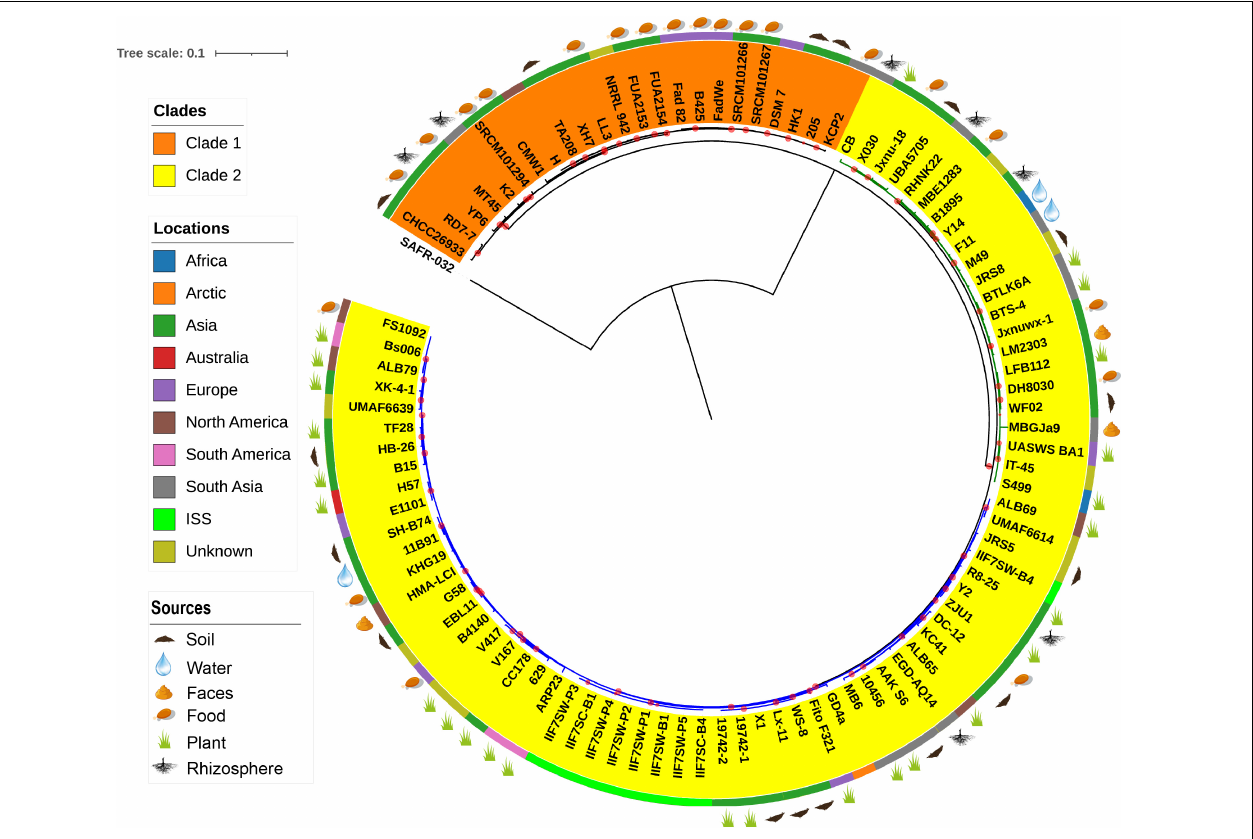
FIGURE 2 | The phylogenetic tree of single-copy core proteins. The maximum-likelihood tree was constructed by the module “CoreTree” of PGCGAP v1.0.21 (Liu et al., 2020) with the best fit model JTT+F+R4. The tree was rooted against Bacillus pumilus SAFR-032 as an appropriate outgroup. Red circles on the branch represent bootstrap values larger than 80%. The background color of the labels (colored ranges) represents the clades, and the green and blue branches represent cluster 1 and cluster 2 of clade 2, respectively. The color strip outside the tree describes where the strain was isolated; ISS means International Space Station. The cartoons outside the tree indicate that the strain was isolated from soil, food, rhizosphere, water, or faces of herbivores, or is associated with the